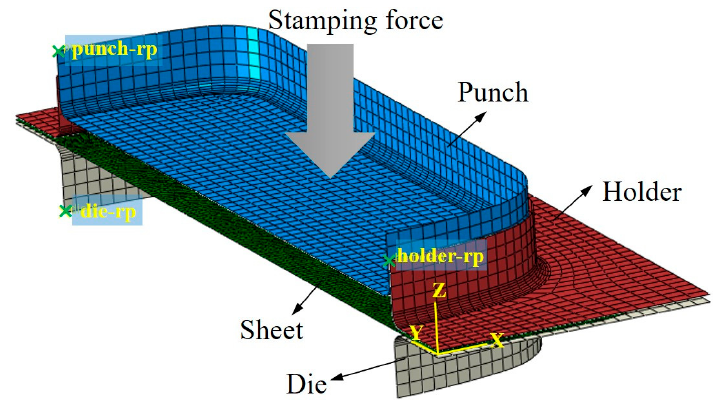
Figure 1. Three-dimensional coupled thermomechanical finite element model of the hot-stamping process. process.